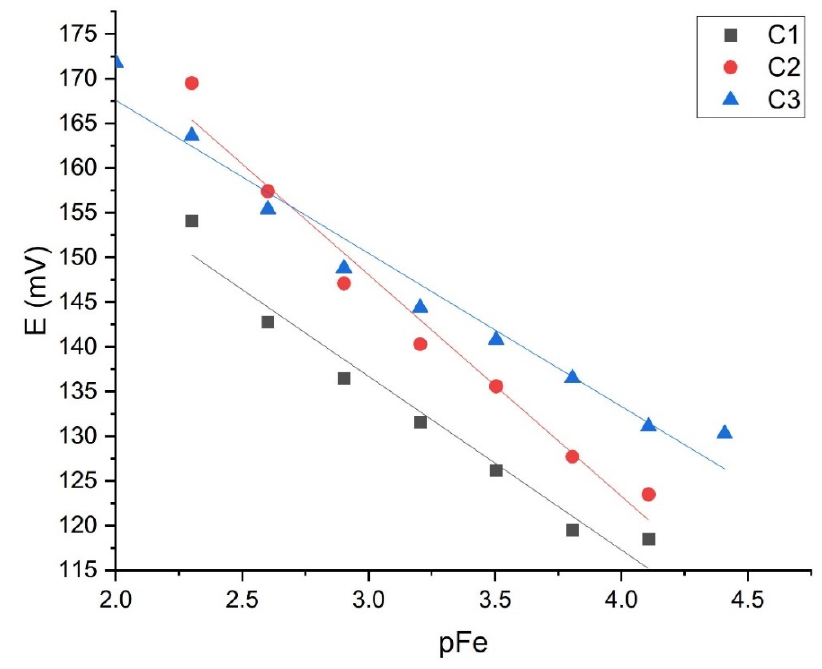
Figure 10. M1 intraday testing ( n = 3).